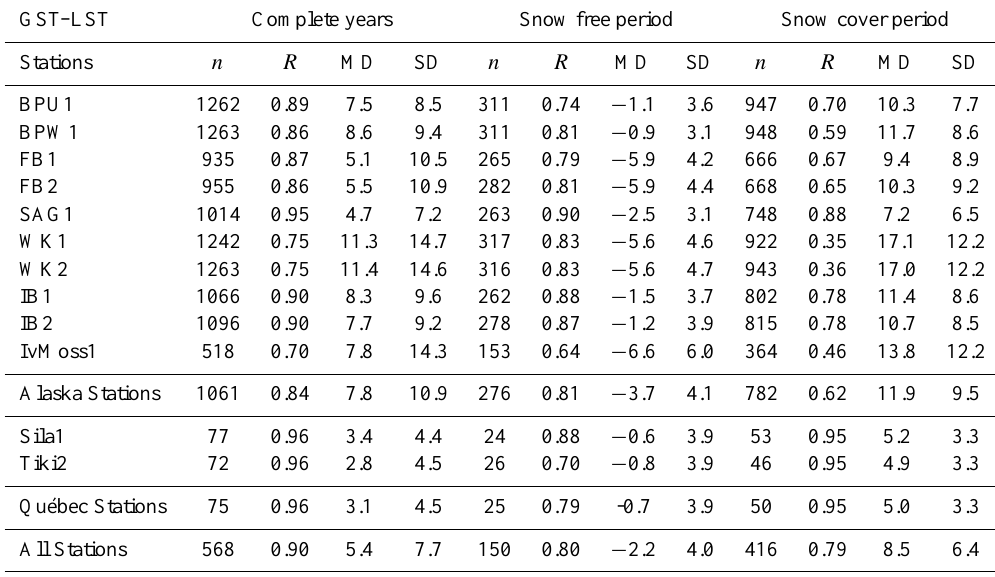
Table 6. Mean Difference (MD), Standard Deviation (SD) and Correlation ( R ) between GST and LST during complete year, snow free and snow cover periods for Aqua/Terra